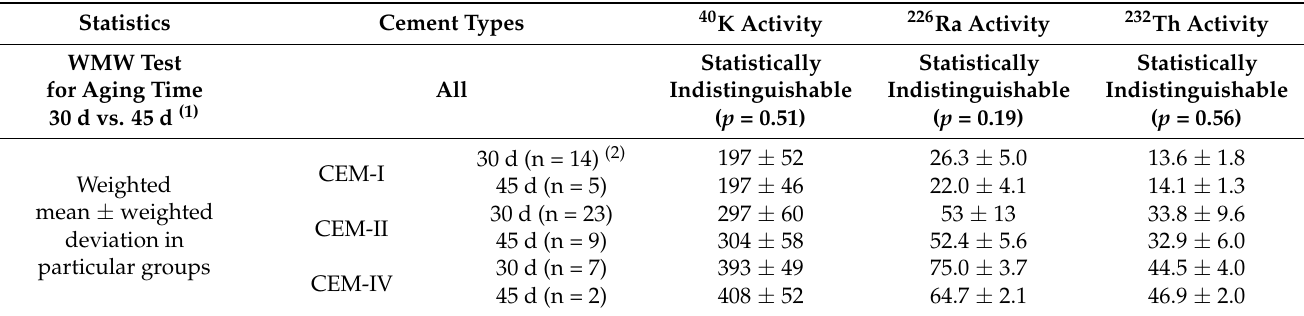
Table 8. Descriptive statistics and results of statistical tests performed to verify whether there exists a statistically significant difference between activity of 40 K, 226 Ra, and 232 Th in the cases of shorter and longer aging time. WMW tests have been conducted with no division into groups of various cement types, while weighted means with weighted deviations have been calculated within these